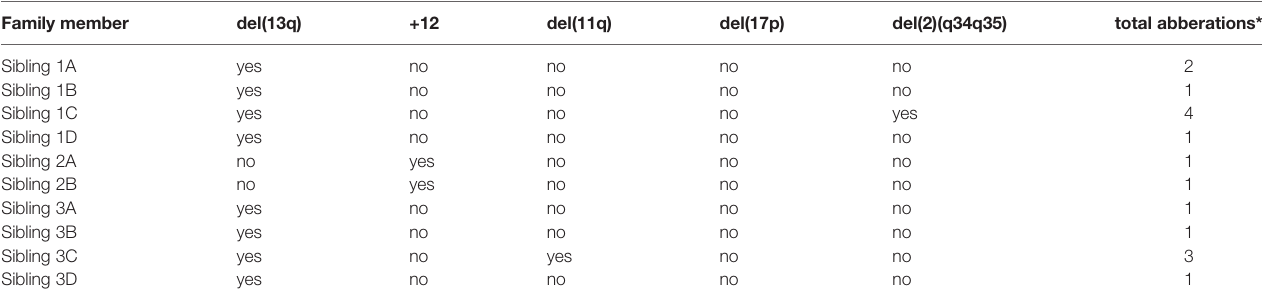
TABLE 2 | Cytogenetic aberrations encountered for each of the three families. Family